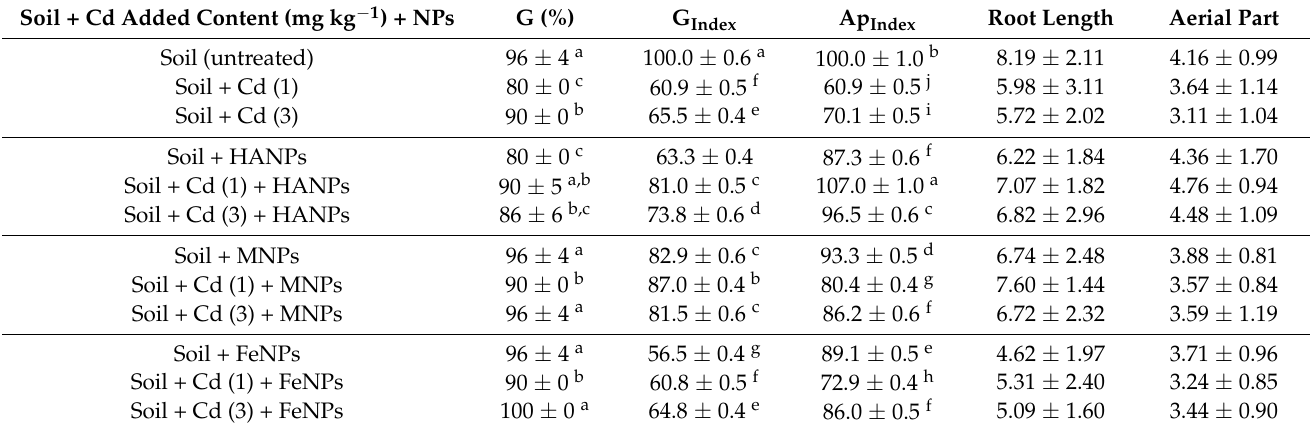
Table 3. Germination percentage G (%), root length and aerial part (cm), germination index (G Index ), and index of influence on the aerial part (Ap Index